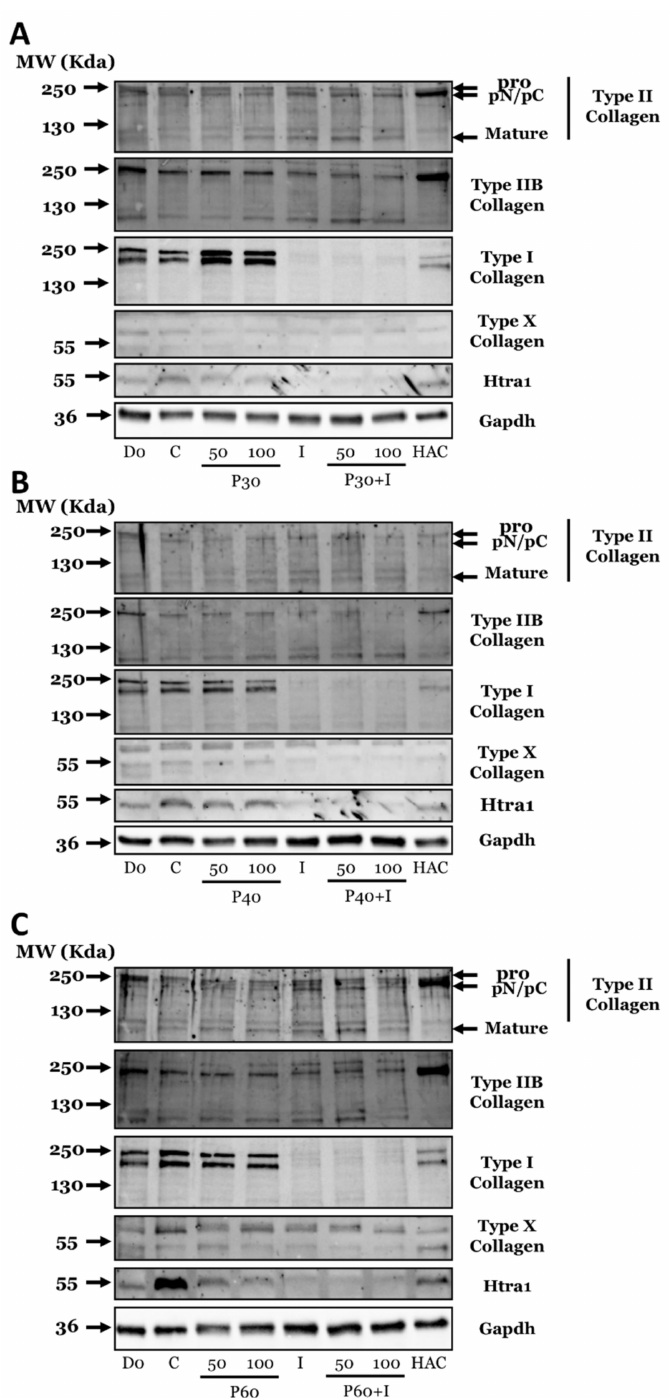
Figure 10. Effect of high concentrations of Promerim ® hydrolysates on collagens and HtrA1 protein expression of human articular chondrocytes. Human articular chondrocytes at P2 were inoculated in collagen sponges and treated for 7 days in the absence or presence of IL-1 β (10 ng/mL) with Promerim ® 30 ( A ), 40 ( B ) or 60 ( C ) at 50 and 100 µ g/mL. The 3D control culture medium was used as control (Ctrl), I (IL-1), P30 (Promerim ® 30), P40 (Promerim ® 40), P60 (Promerim ® 60). Cells seeded in sponges stopped at day 0 (D0) and protein extracts obtained from human articular cartilage (HAC) are also shown. The molecular weights expressed in kDa are shown on the left-hand side of the panels and the target proteins on the right-hand side of the panels. Images show representative immunoblots from different HAC strains (at least n = 3). Full membranes are shown in Figure S11 as well as under-exposed and over-exposed blots in Figures S12 and S13,